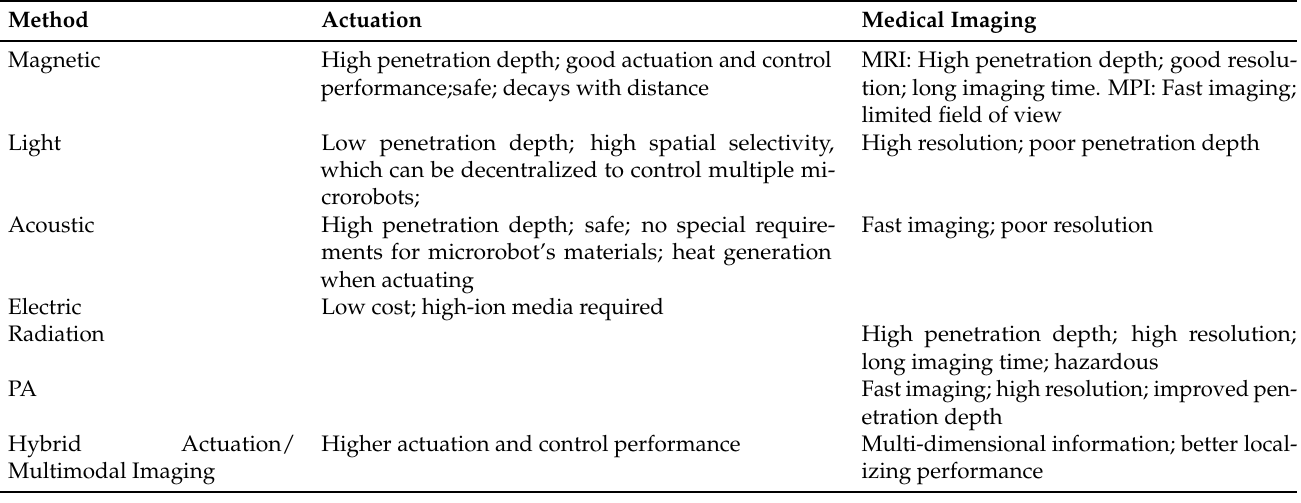
Table 3. Advantages and limitations of different